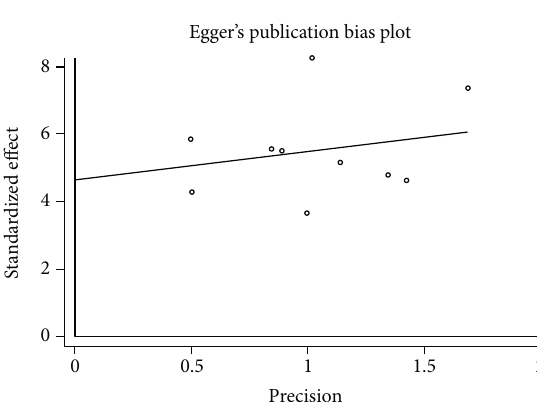
Figure 12: Publication bias of T2 signal